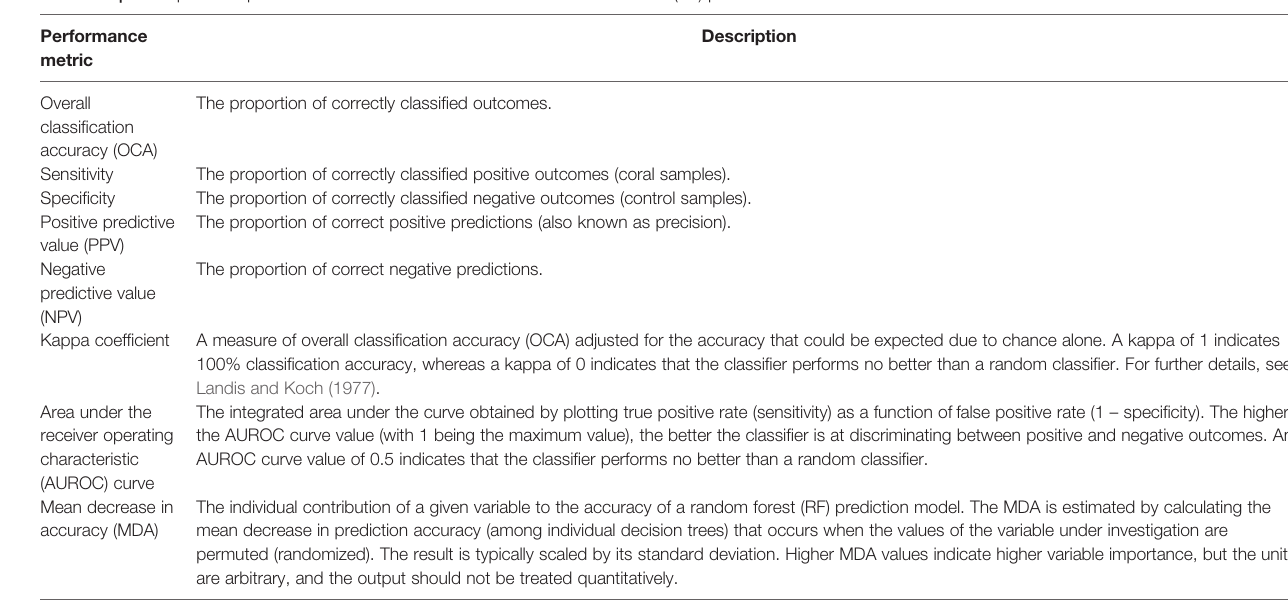
( Figure 4A ). Based on the hyperspectral SVM classi fi cation ( Figure 4B ), live reef structures (i.e., white D. pertusum , orange D. pertusum and the sponge Mycale cf. lingua ) were estimated to cover 15.5% of the total UHI survey area and 17.3% of the UHI survey area identi fi ed as coral acoustically ( Table 4 ).